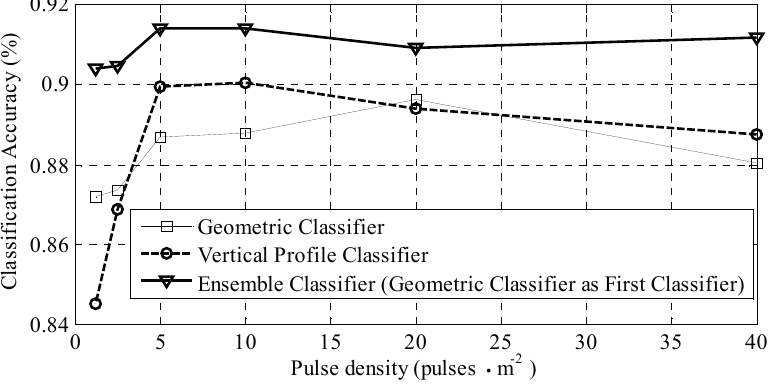
Figure 6. Classification accuracy of the geometric, vertical profile, and ensemble classifiers, using the geometric classifier as the first classifier at different LiDAR pulse density